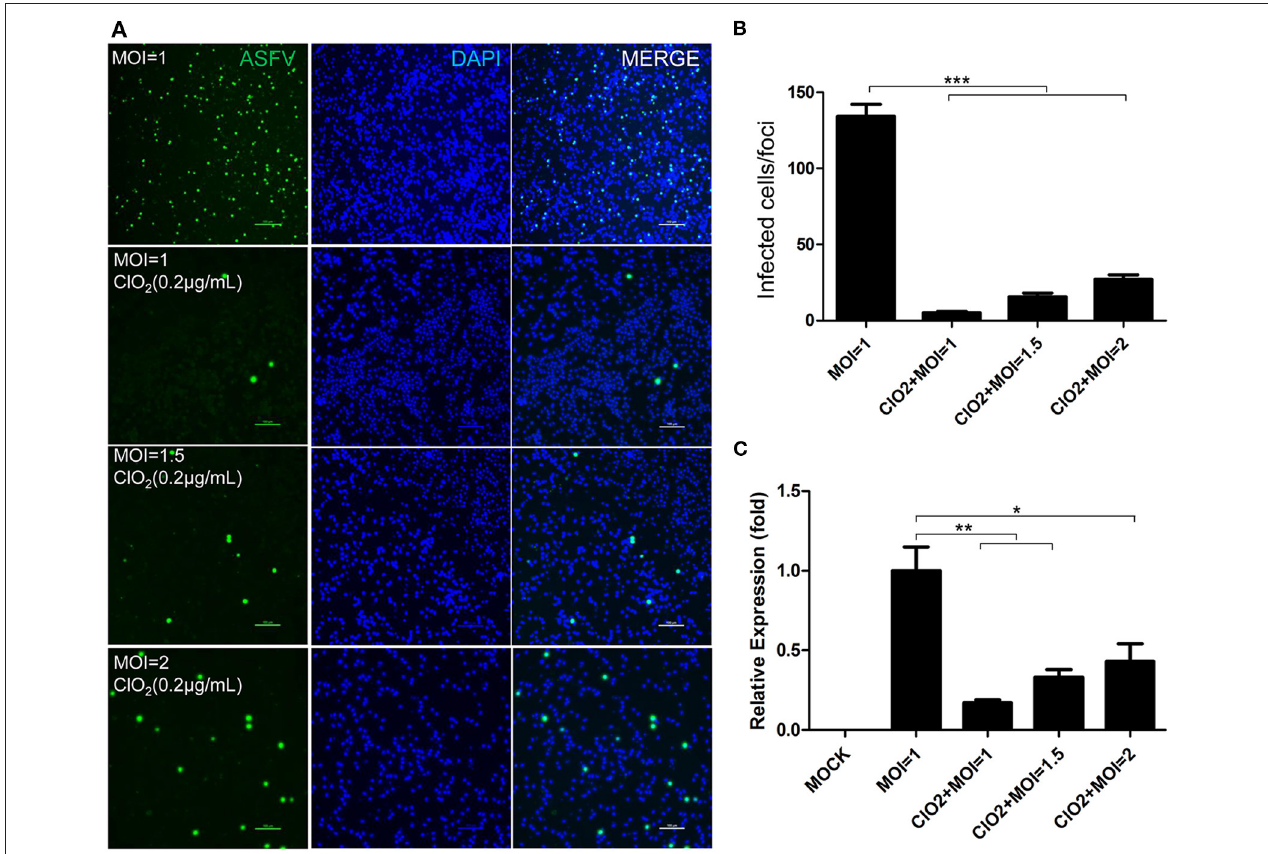
FIGURE 2 | ASFV at different MOIs is inhibited by ClO 2 in PAMs. (A) Cells were inoculated with ASFV at different MOIs in the presence or absence of ClO 2. Cells were then cultured for 24h and IFA was performed to evaluate the viral p30 expression. Bar, 100 µ m. (B) Average number of infected cells per foci. (C) PAMs were mock-infected or infected with ASFV at various MOIs, and simultaneously co-treated with ClO 2 at the indicated concentration. At 24 hpi, cells were measured by qRT-PCR for the determination of the transcription level of viral p72 gene. Data are representative of the results of three independent experiments (means ± SE). Significant differences compared with control group are denoted by * P < 0.05, ** P < 0.01, and *** P <